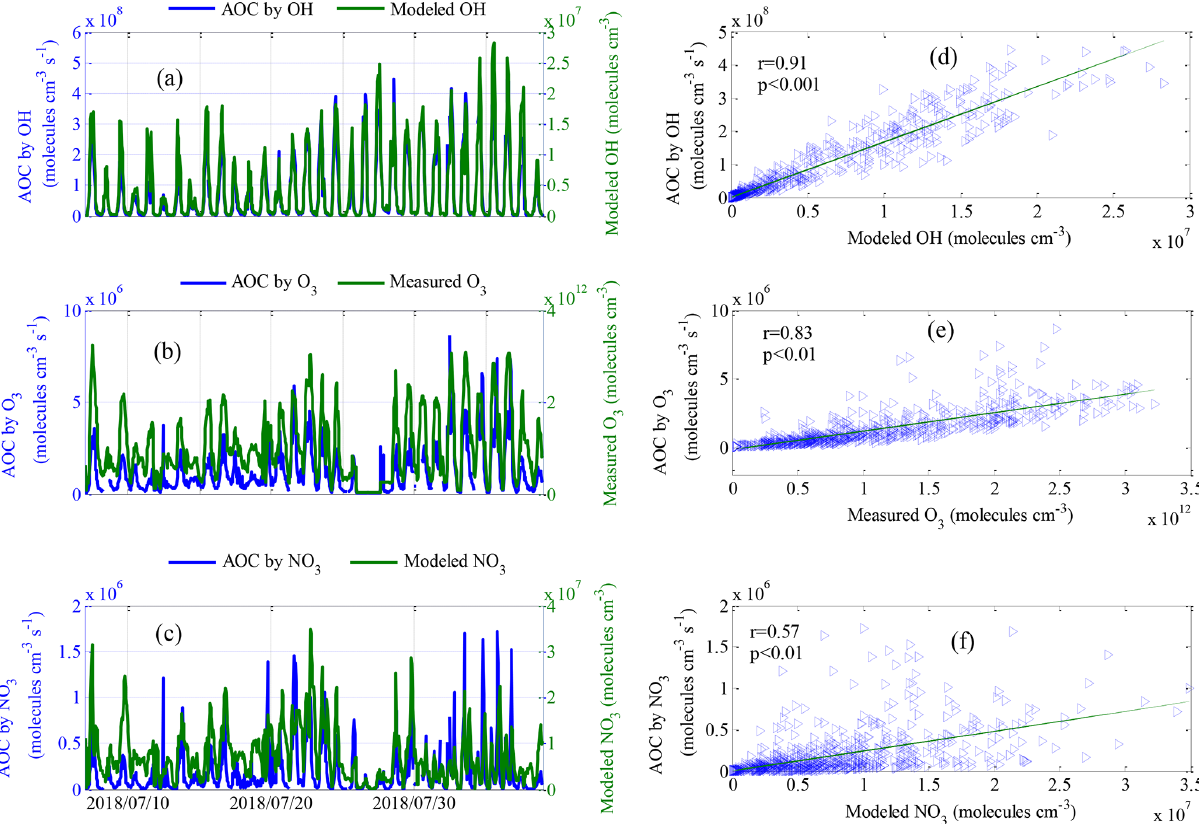
Figure 7. Comparisons of calculated AOC by (a) modeled OH, (b) measured O 3 and (c) modeled NO 3 along with corresponding oxi- dation concentrations. Panels (a) – (c) show the time series, and (d) – (f) show scatterplots of calculated AOC and corresponding oxidation concentrations. Note: r and p are the correlation coefficient and the significance level,